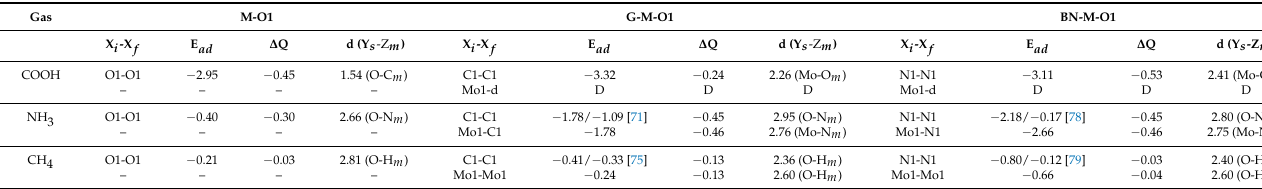
Table 4. (X i -X f ) refers to the adsorbed site (before-after) relaxation, E ad is the adsorption energy (eV). The closest distance between the sheet and molecule is d(Y s -Z m ) (Å) where Y s and Z m indicate the sheet atom and the adsorbed molecule atom, respectively, and ∆ Q (e) refers the charge transfer where a negative sign means the charge is transferred from the structure to a molecule. C H and (B,N) H mean the final position is at the hexagonal ring of G and h -BN, respectively. The “D” indicates the dissociation of the molecule. The references in the adsorption energy columns refer to the corresponding values of the adsorbents on the pristine G and h -BN